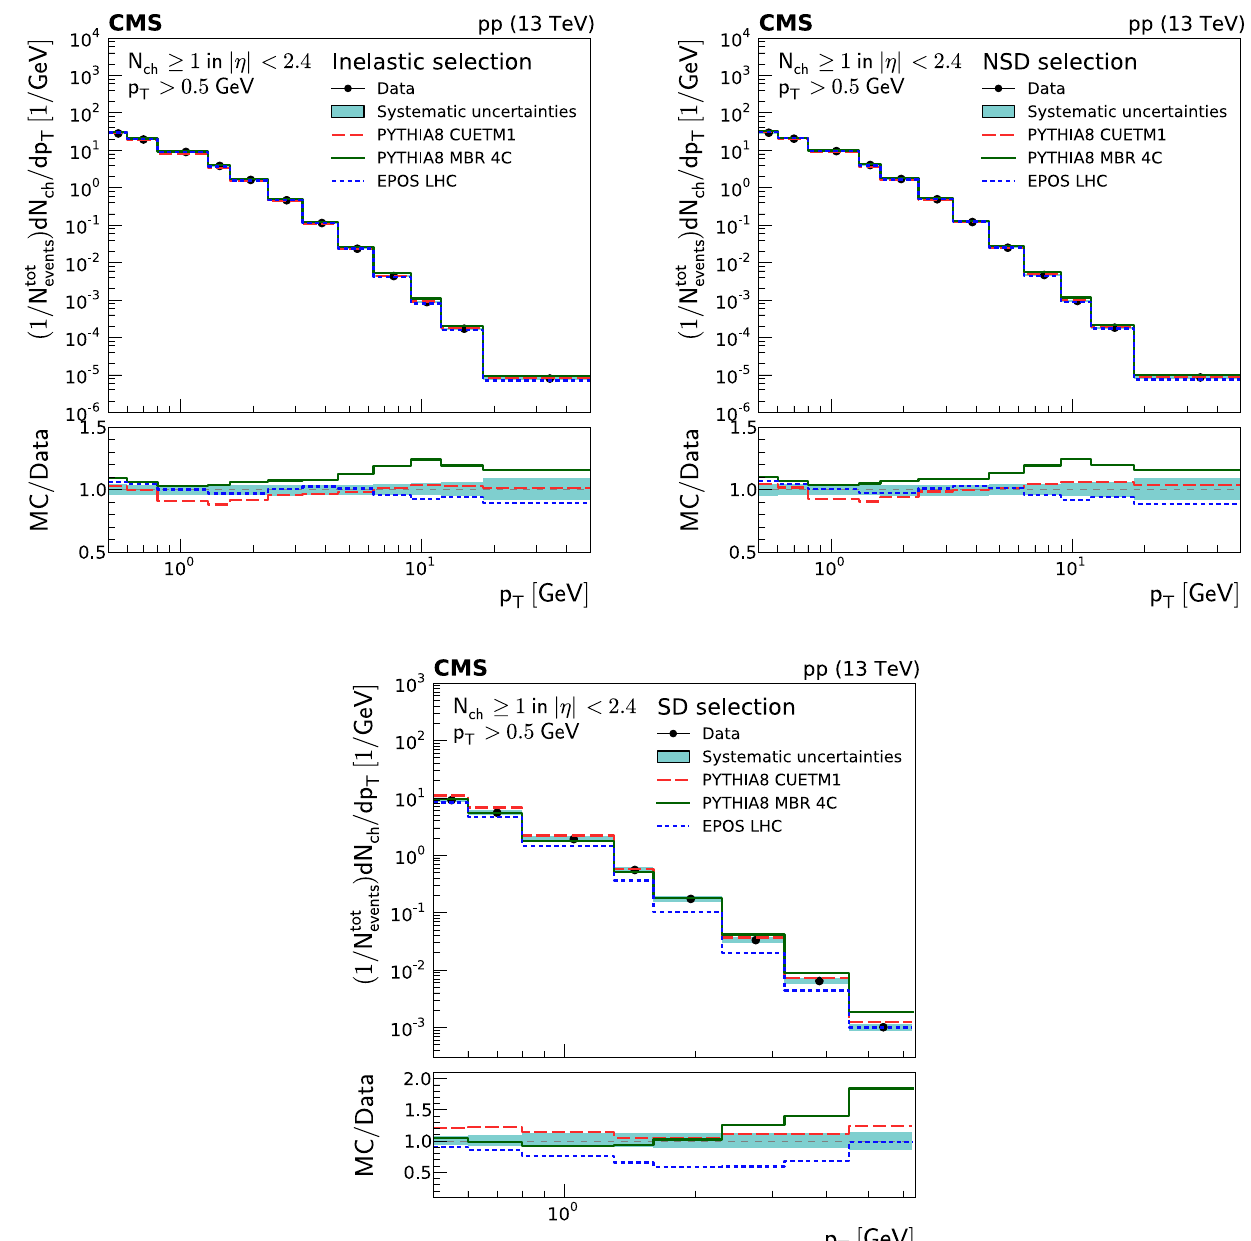
epos LHC (short dashes) event generators. The band encompassing the data points represent the total systematic uncertainty, while the statis- tical uncertainty is included as a vertical bar for each data point. The lower panels show the corresponding MC-to-data